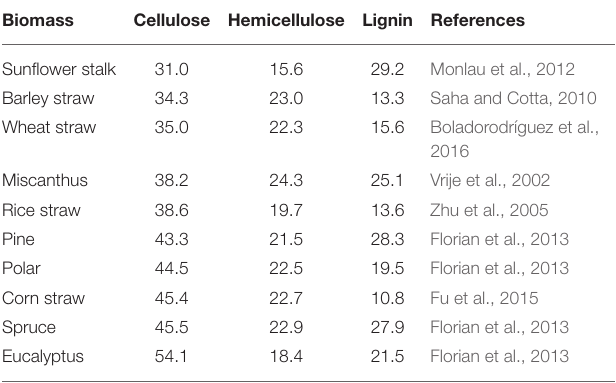
TABLE 2 | Biochemical composition of selected lignocellulosic biomass (w/w, %). Biomass Cellulose Hemicellulose Lignin